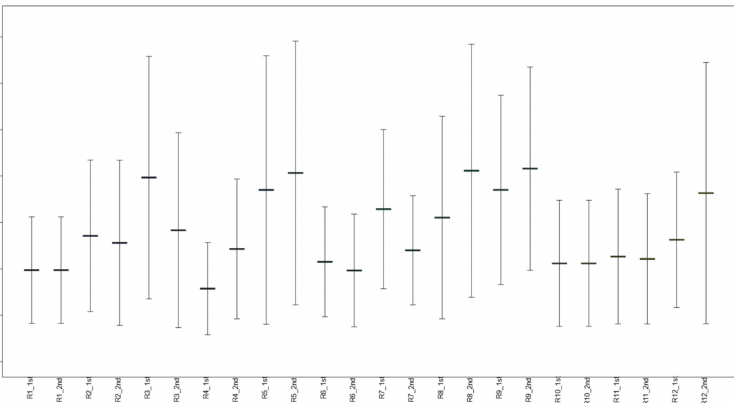
Figure 1. Range of values detected in the 24 inspections. Rx = room number. 1st = first inspection. 2nd = second inspection.